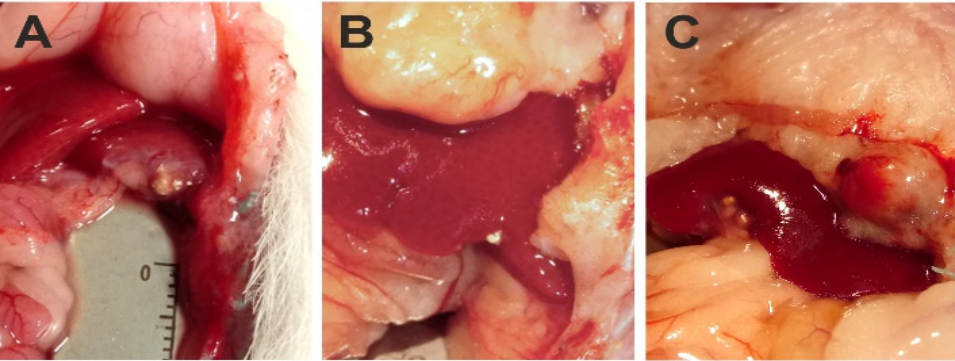
Figure 8. The tumor identification: ( A )—before the drug administration, ( B )—after FR-SOR@PPF treatment, ( C )—regional (pre-hepatic space) metastatic tumor in control animal.